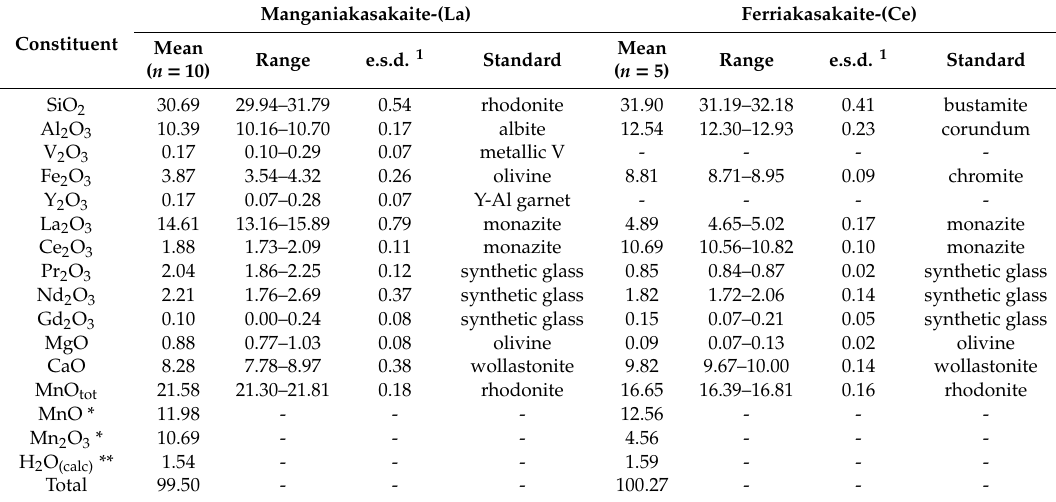
Table 1. Chemical composition (in wt %) of holotype manganiakasakaite-(La) and ferriakasakaite-(Ce).